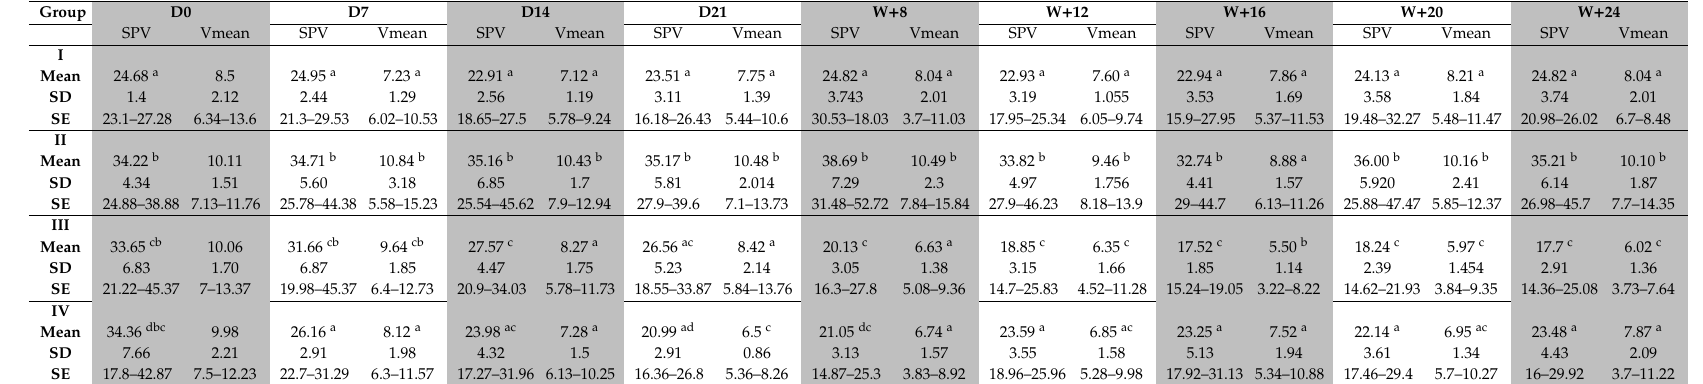
Values in columns with di ff erent letters di ff er ( p <